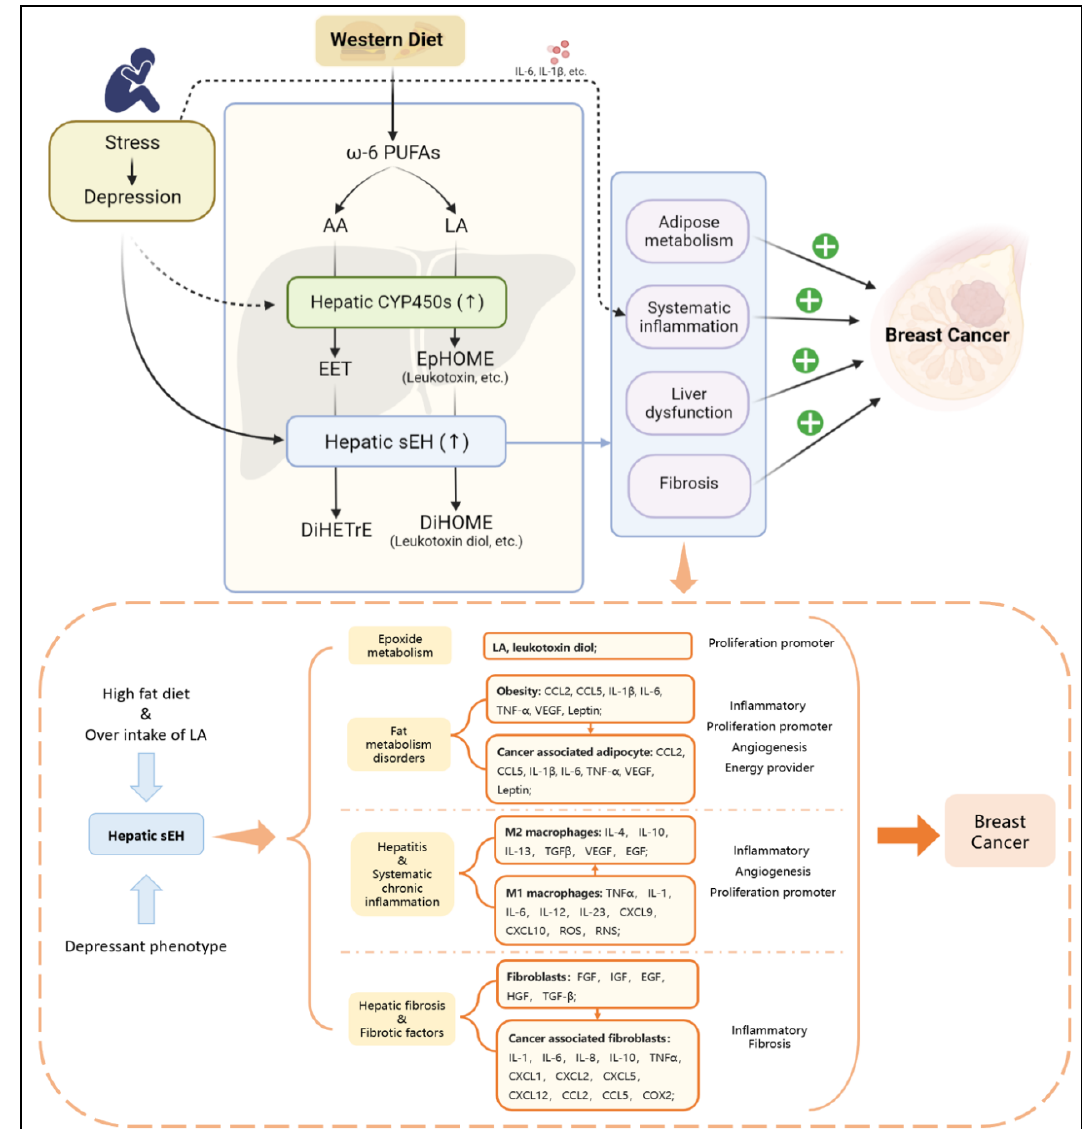
Figure 3. The depressant phenotype can stimulate the specific upregulation of hepatic sEH, while a high-fat diet (especially overintake of LA) can cause an excessive level of LA in the body. The secondary effects related to BC have four types of risk factors: epoxide metabolism, fat metabolism disorders, hepatitis and systematic chronic inflammation, hepatic fibrosis and fibrotic factors. The risk factors can promote BC via angiogenesis, inflammation, fibrosis in TME, and progression of